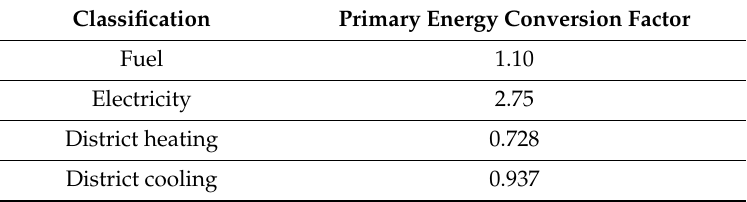
Table 9. Primary energy conversion factors by fuel